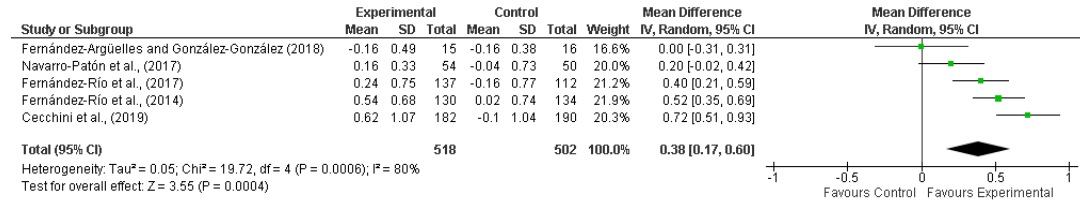
ff ect sizes for intrinsic motivation of cooperative learning Figure 2. Meta-analysis: effect sizes for intrinsic motivation of cooperative learning interventions. Figure 2. Meta-analysis: e